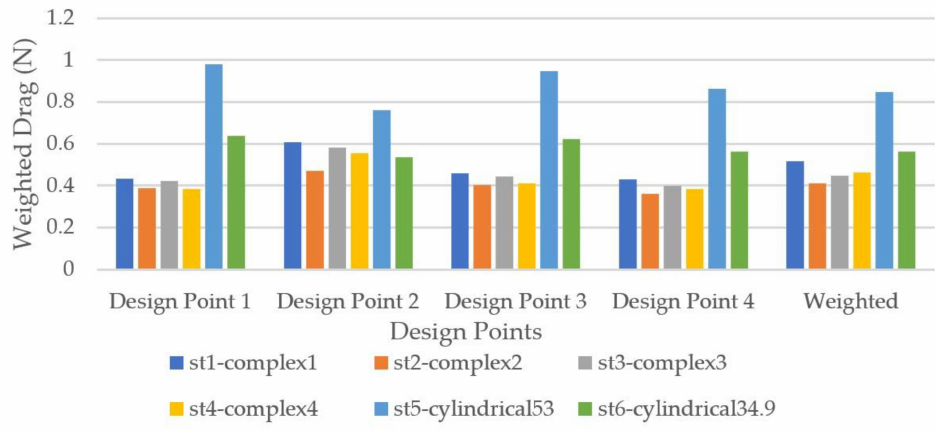
Figure 28. Weighted drag force on seat tube cross-sections.